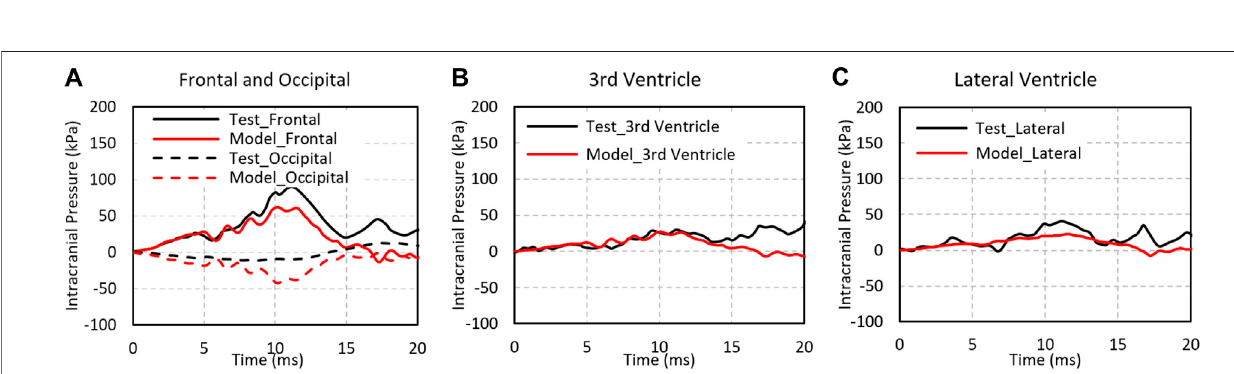
the rubber skin, and the slope between 0.5- and 1.4-cm displacement where the slope is approximately linear was de fi ned as the stiffness/compliance. The simulated F-D curves fell well within the corridor of the experimental results. The